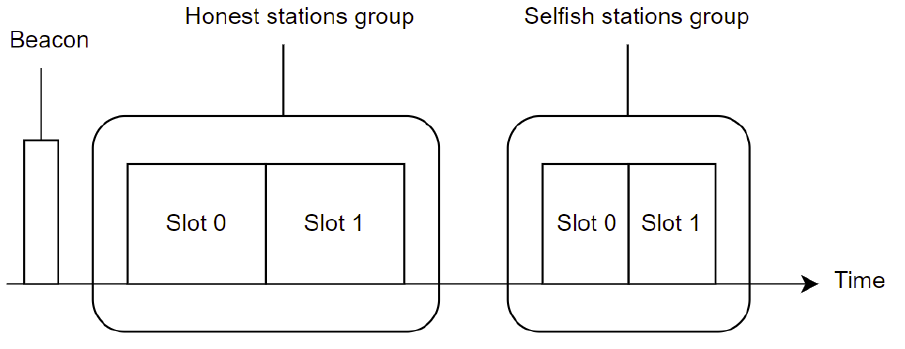
Figure 11. SSQPA RAW